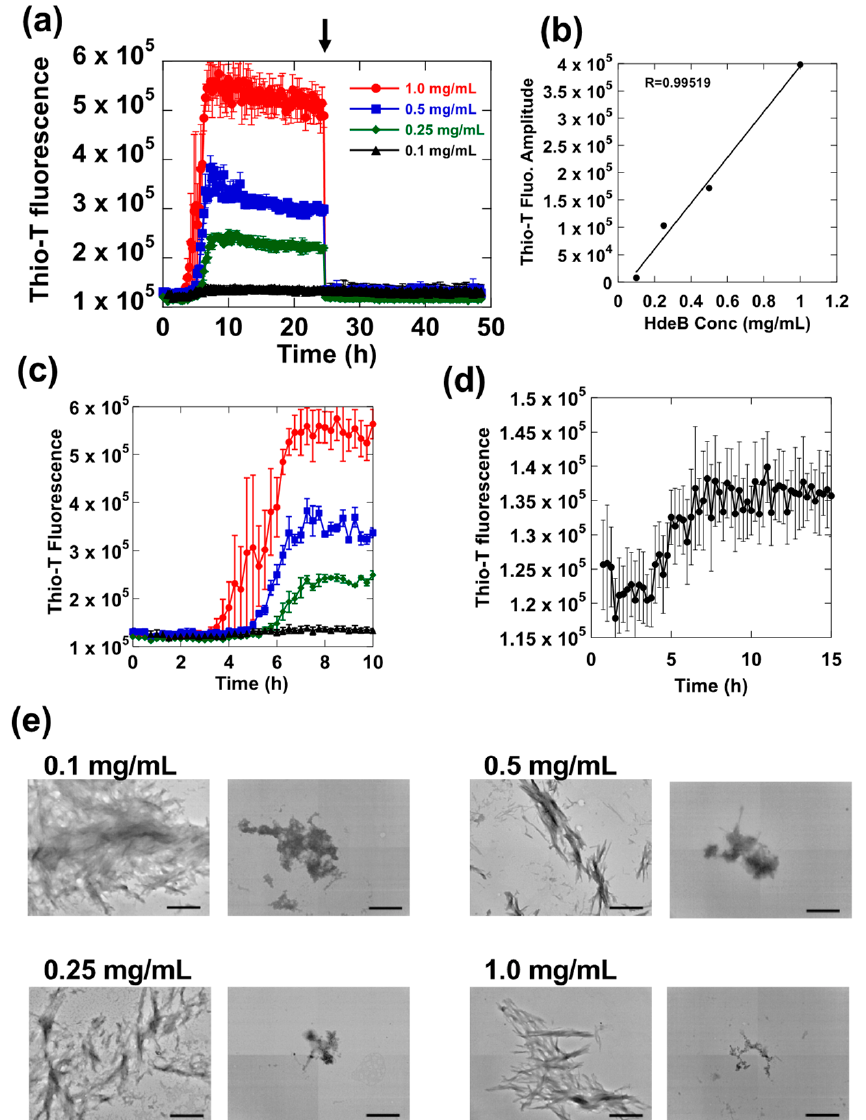
Figure 2. Fibrillation of HdeB at different concentrations. Samples of HdeB in various concentrations ranging from 0.1 mg/mL to 1.0 mg/mL were incubated with shaking in 20 mM Gly-HCl, pH 2.0, containing 250 mM NaCl. Thio-T fluorescence was monitored periodically to obtain the fluorescence traces shown in panel ( a ). The pH of each sample was shifted to 7 with addition of Tris base at the time depicted by the arrow. Panels ( b ) through ( d ) are derived from the initial data shown in ( a ); panel ( b ) shows the dependence of the net Thio-T fluorescence change during the fibril-forming reaction (derived by subjecting the raw fluorescence value at t = 0 from the fluorescence value at t = 24 h of each sample) on the HdeB concentration. Panel ( c ) is an expanded view of the first 10 h of the assay that facilitates observation of changes in lag time for each sample. Panel ( d ) is a magnified view of the 0.1 mg/mL HdeB sample, which was difficult to discern in the traces in panels ( a , d ). Panel ( e ); TEM images taken from each sample before and after the shift to pH 7, denoted by the arrow in panel ( a ). Magnification of the images were fixed at × 20,000, and the scale bar denotes 500 nm.